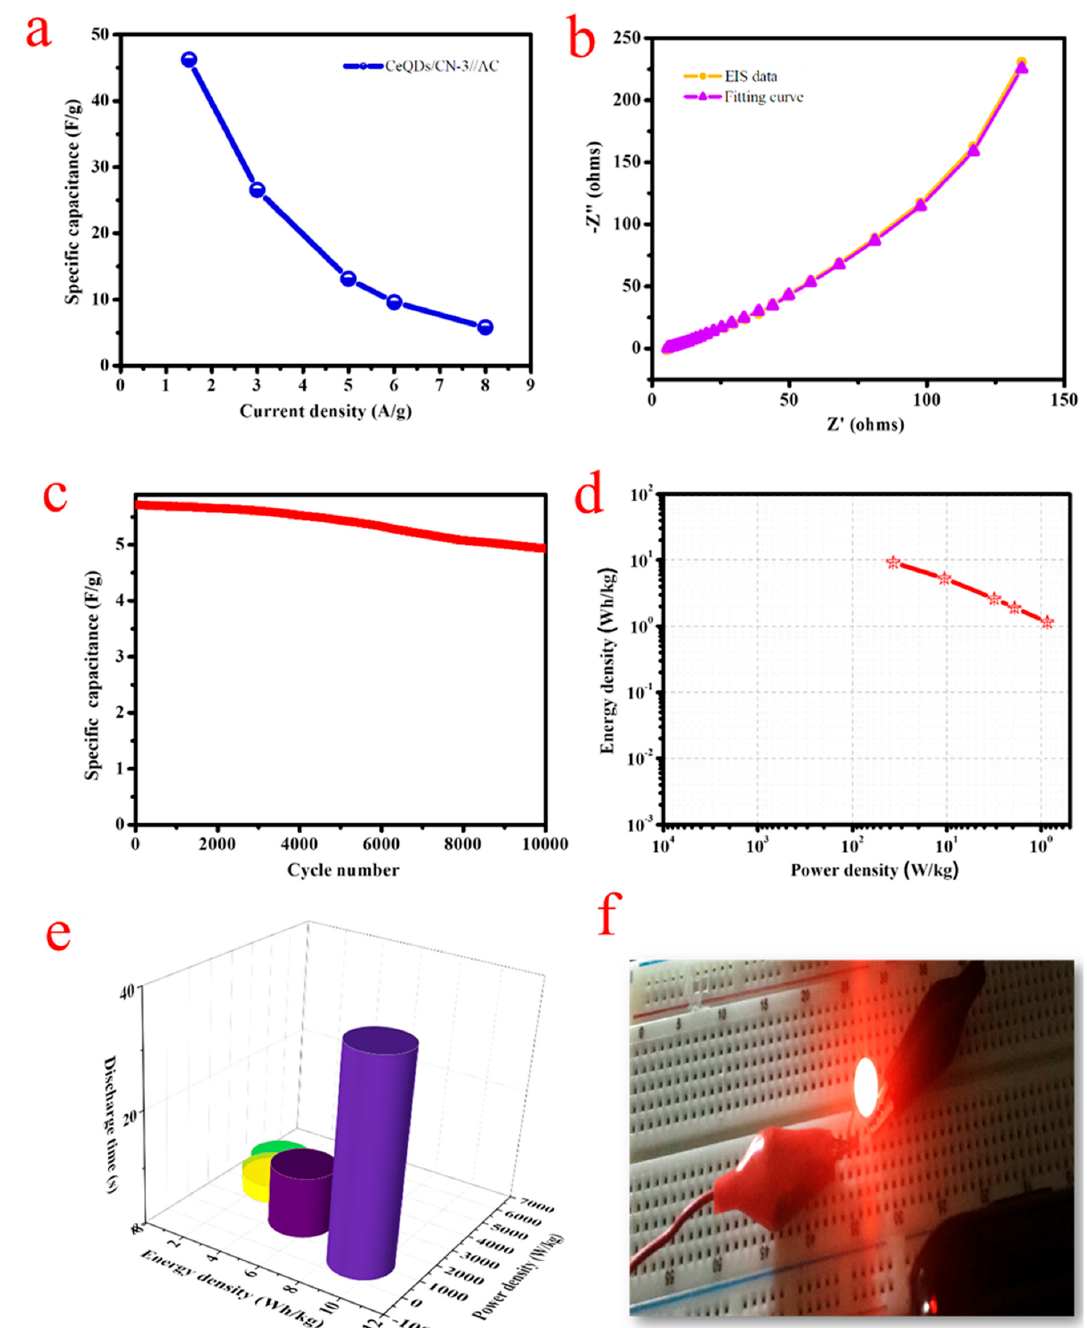
Figure 8. ( a ) Specific capacitance vs. current densities, ( b ) Nyquist plot with fitting curves of HCASD, ( c ) stability of the HCASD tested at 8 A/g, ( d ) Ragone plot, ( e ) 3D plot of energy density vs. power density vs. discharge time, and ( f ) practical applications of the CN/CeQDs-3//AC HCASD device: digital images of a red LED lit by the two HCASD.